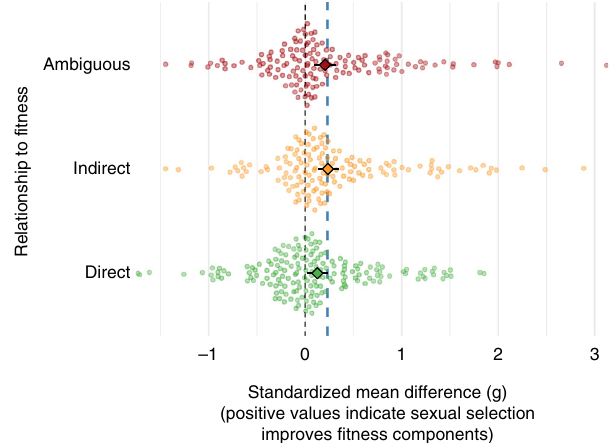
Fig. 1 The effect of sexual selection on direct, indirect and ambiguous fi tness components. The effect sizes used in this meta-analysis ( n = 459) were grouped into either direct, indirect or ambiguous measures of fi tness. Overall, effect sizes were more often positive than negative. Predicted average values are presented as a diamond with 95% con fi dence intervals (CIs) for each fi tness-relationship category. The estimates presented here are from restricted maximum likelihood (REML) models with the grand mean across all effect sizes ( β = 0.25) shown as the blue dotted line. Predictions from both Bayesian and REML models can be found in Supplementary Table 6. Data used for generating this fi gure are available in the Source Data fi